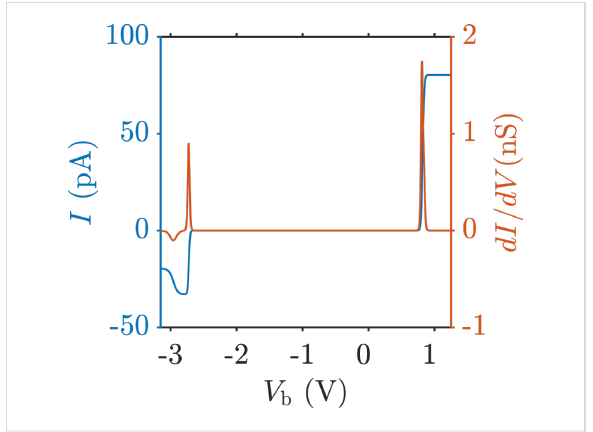
Figure 4: Current and differential conductance curves exhibiting the anionic (cationic) resonance at positive (negative) bias voltage. Note that in contrast to all other results in this work, this curve is taken at a temperature of 60 K to emphasize the resonances in the dI / dV curve.